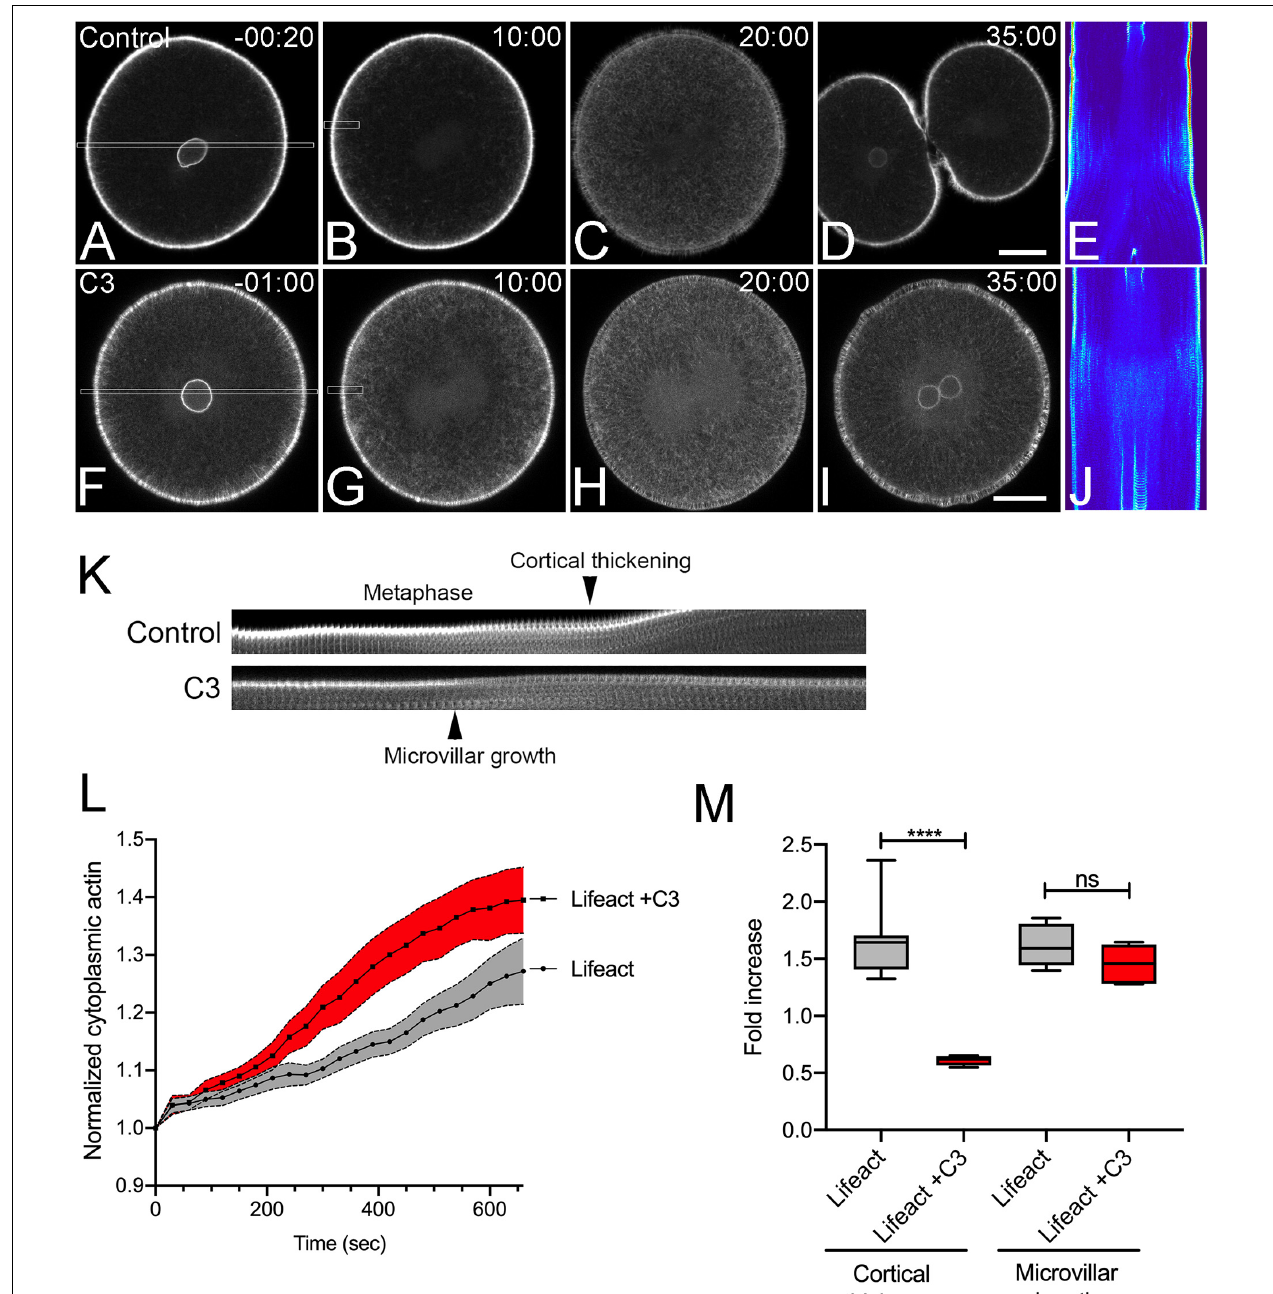
FIGURE 1 | Actin dynamics in the dividing sea urchin embryo. Frames from time-lapse movies of L. variegatus embryos injected with either recombinant Lifeact-GFP ( A–E , final intracellular concentration of 0.21 µ M) or Lifeact-GFP and C3 Transferase ( F–J , final intracellular concentration 0.27 µ M). Bar, 30 µ m. Time points denote minutes post-nuclear envelope breakdown (NEB). (E,J) Corresponding kymographs of sections taken through the long axis of the spindle as denoted by the rectangles in panels (A,F) . Prior to nuclear envelope breakdown a bright rim of perinuclear actin is visible (A,F) . Upon mitotic entry, microvilli and their rootlets shorten, and there is a gradual increase in deep cytoplasmic actin initiating at the cortex and accumulating inward up until anaphase onset (C,E,H,J) . (K) Kymograph of cortical microvillar dynamics in the polar regions of control- and C3-injected embryos, taken from regions denoted by the small rectangles in Panels (B,G) . (L) Quantification of cytoplasmic actin levels beginning 1 min post-NEB up until the metaphase-anaphase transition (Mean ± SEM, n = 6 cells per condition). While there was not a qualitative effect of Rho inactivation on cytoplasmic actin, there was a significant increase in cytoplasmic Lifeact fluorescence in C3-injected embryos. (M) Quantitation of the increases in cortical thickness and microvillar length that accompanies the metaphase-anaphase transition in control and C3-injected embryos ( n = 6 cells per condition, whiskers denote minimum and maximum values), where a value of 1.0 represents length or thickness 1 min prior to the metaphase-anaphase transition. While there was no significant difference in the growth of microvilli, Rho inactivation blocked the thickening of actin cortex. **** p < 0.0001.